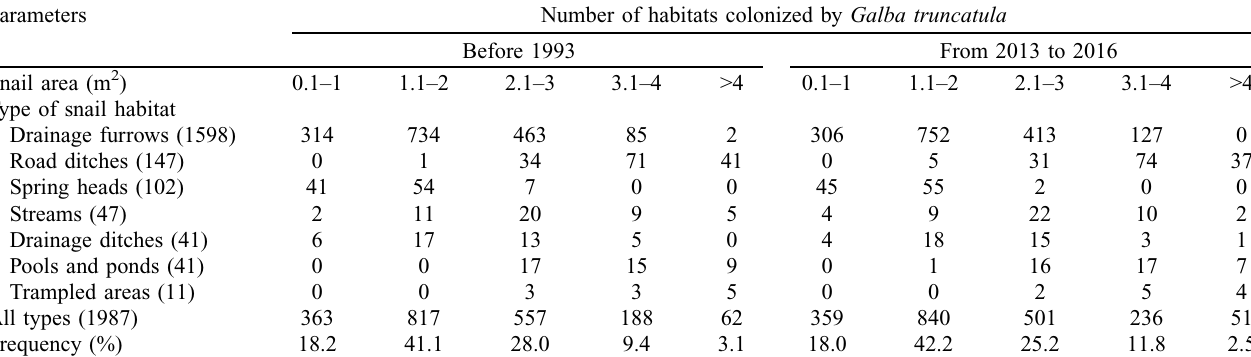
Table 3. Distribution of 1987 habitats colonized by Galba truncatula on the 162 farms before 1993 and in 2013–2016 in relation to the type and area of habitat. The total number of snail habitats is given after each type of habitat (first column).